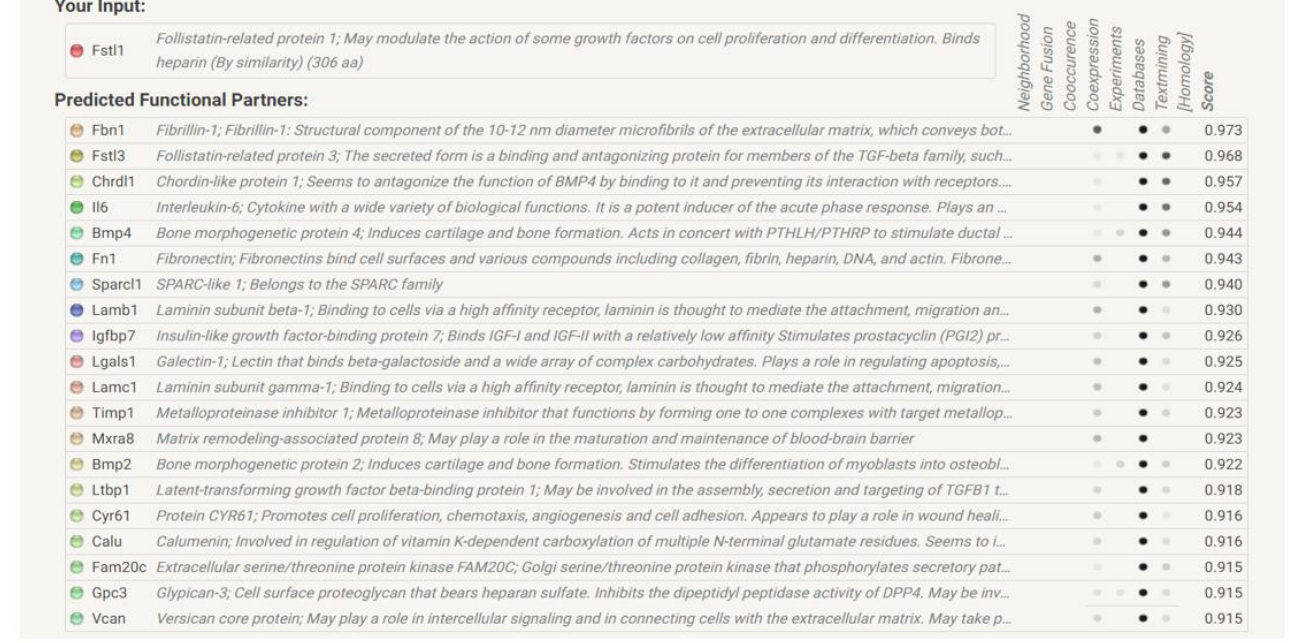
Figure 15. STRING interaction map showing protein–protein association between Fstl1 and 20 proteins.